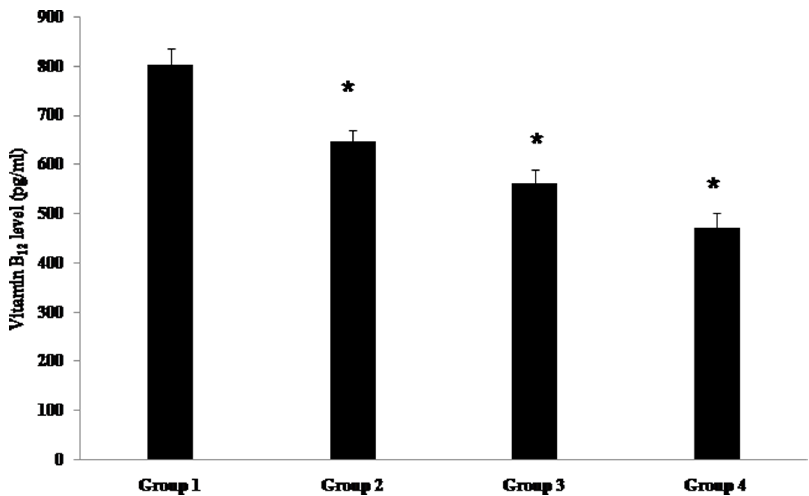
Figure 2. The mean value of vitamin B 12 according to daily sulfonylurea dosage (* P , 0.05 vs. Group 1). Group 1 : glimepiride 1 mg, gliclazide 80 mg, gliclazide MR 30 mg, and glibenclamide 5 mg (n=40); Group 2 : glimepiride 2 mg, gliclazide 160 mg, gliclazide MR 60 mg, and glibenclamide 10 mg (n=116); Group 3 : glimepiride 3 mg, gliclazide 240 mg, gliclazide MR 90 mg, and glibenclamide 15 mg (n=56); and Group 4 : glimepiride 4 mg, gliclazide 320 mg, gliclazide MR 120 mg, and glibenclamide 20 mg (n=87).